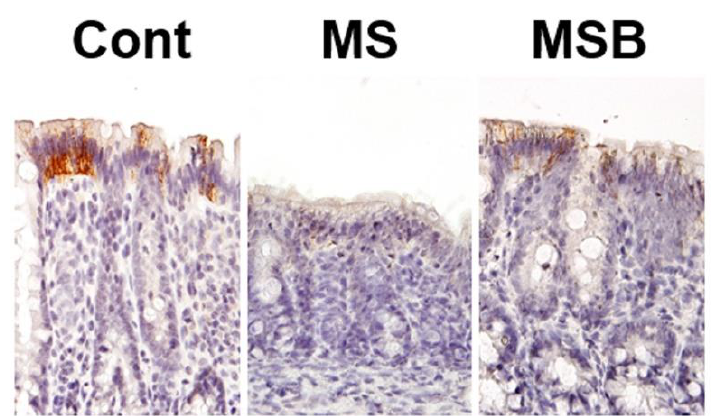
Figure 3. Effect of probiotic BBG9-1 on claudin 4 expression in the colonic mucosa of MS rats. Cont, control; MS, maternal separation; MSB, MS with BBG9-1 treatment. The attenuated immunoreactivity of claudin 4 in MS rats was restored by the treatment with BBG9-1 (magnification ×400).